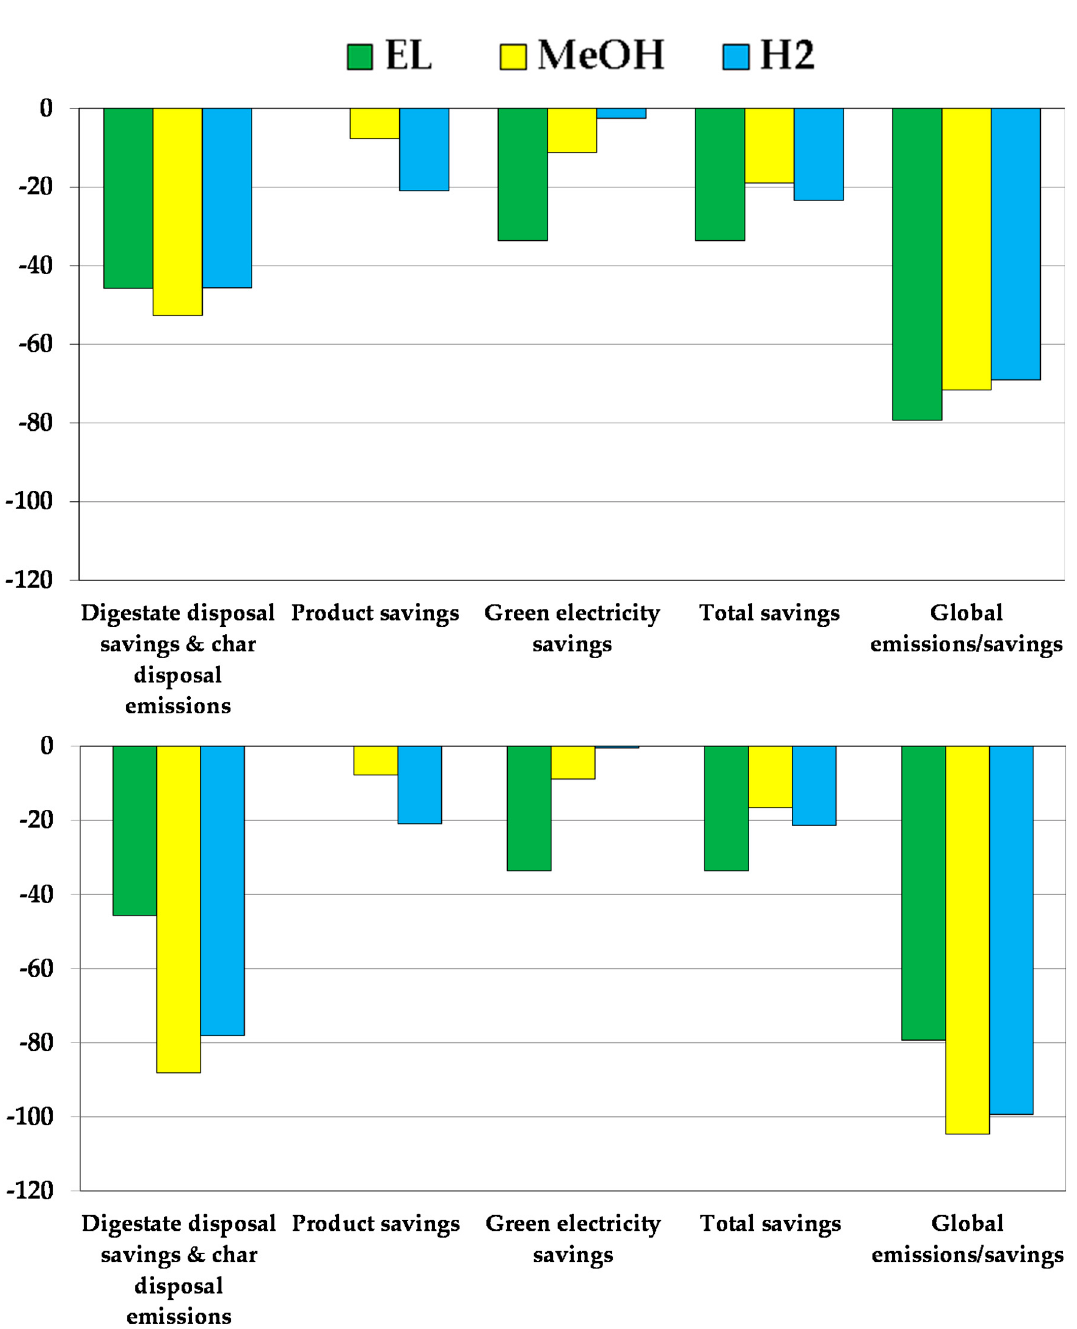
Figure 8. Annual CO 2 equivalent emissions (ktCO 2 ,eq) for EL case (green bars), Case-MeOH (yellow bars), and Case-H2 (blue bars) without CO 2 sequestration (up) and with CO 2 sequestration (down).